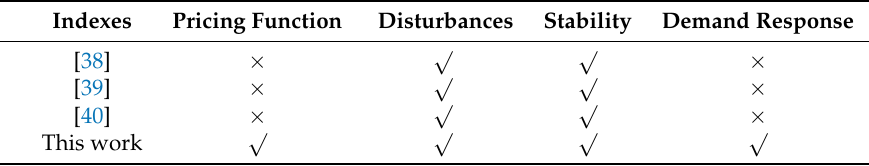
Table 1. Differences of the proposed work with the